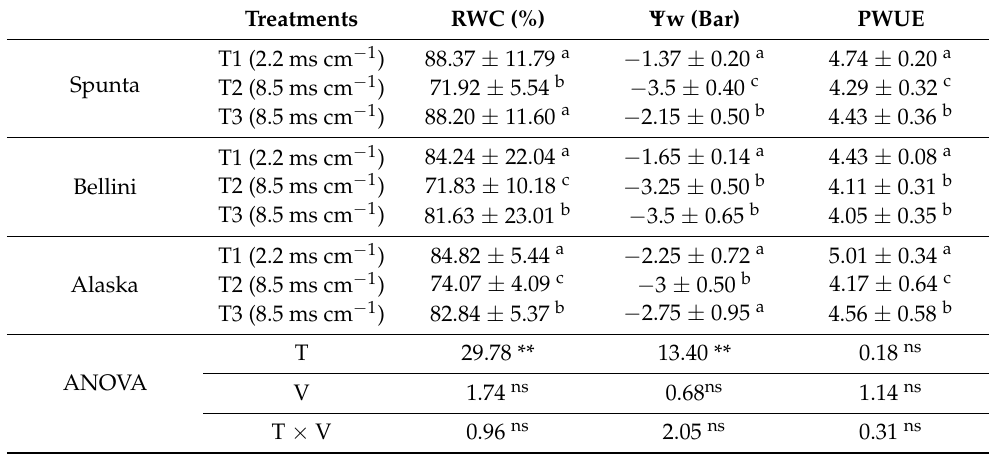
Table 2. Changes in relative water content (RWC), water potential ( Ψ w) and photosynthetic water use efficiency (PWUE) of potato varieties (Spunta, Bellini and Alaska), for each irrigation treatment.